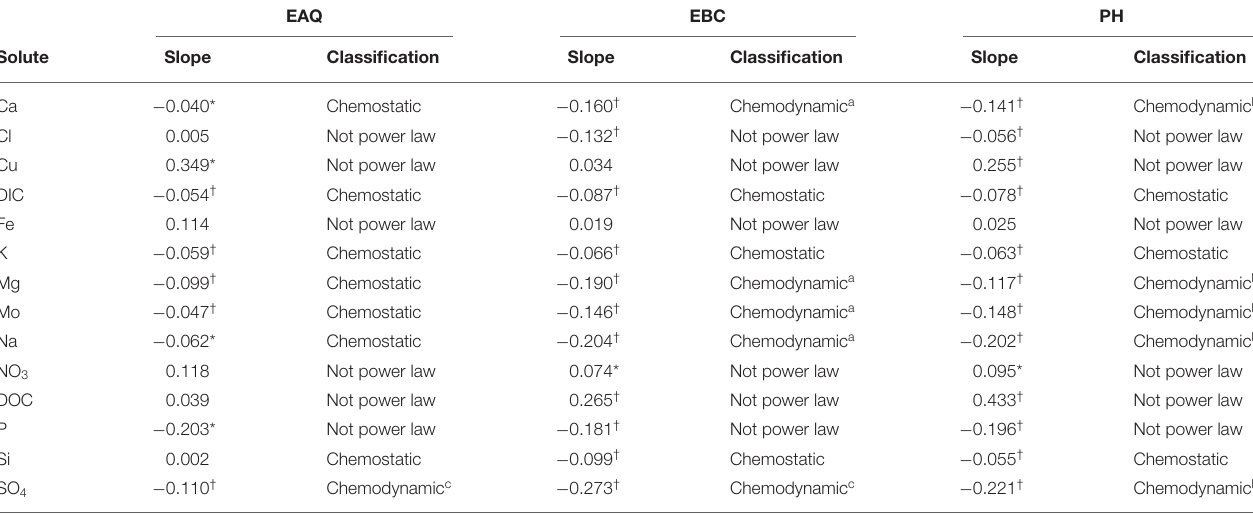
TABLE 3 | Log- log relationship for solutes at all three stations of the East River